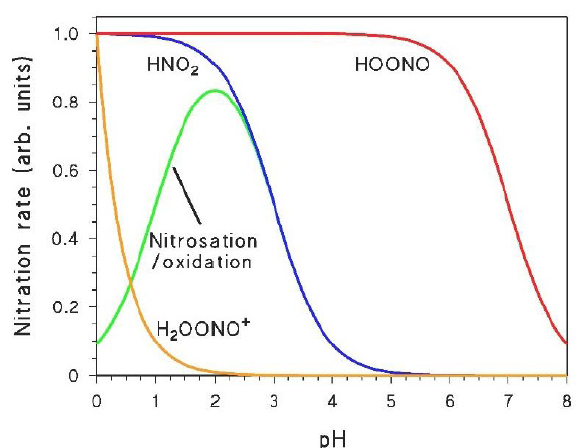
Figure 2. Trends, as a function of pH, of the occurrence of nitrating agents (or of nitration processes) that are produced (or can be triggered) under irradiation.